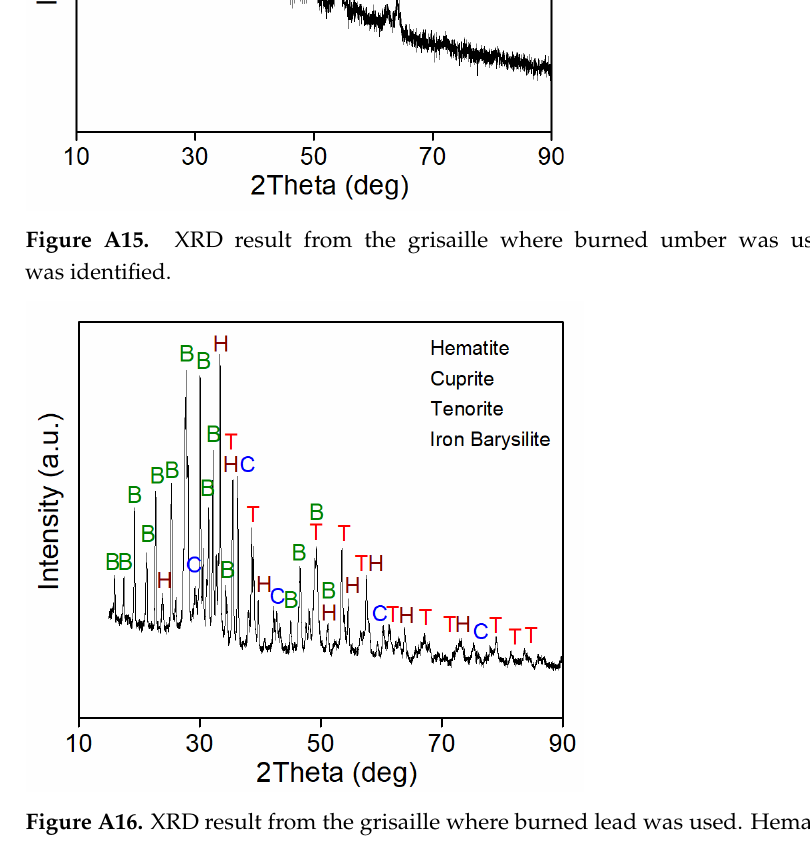
Figure A16. XRD result from the grisaille where burned lead was used. Hematite (H), cuprite (C), tenorite (T), and iron barysilite (B) were identified.